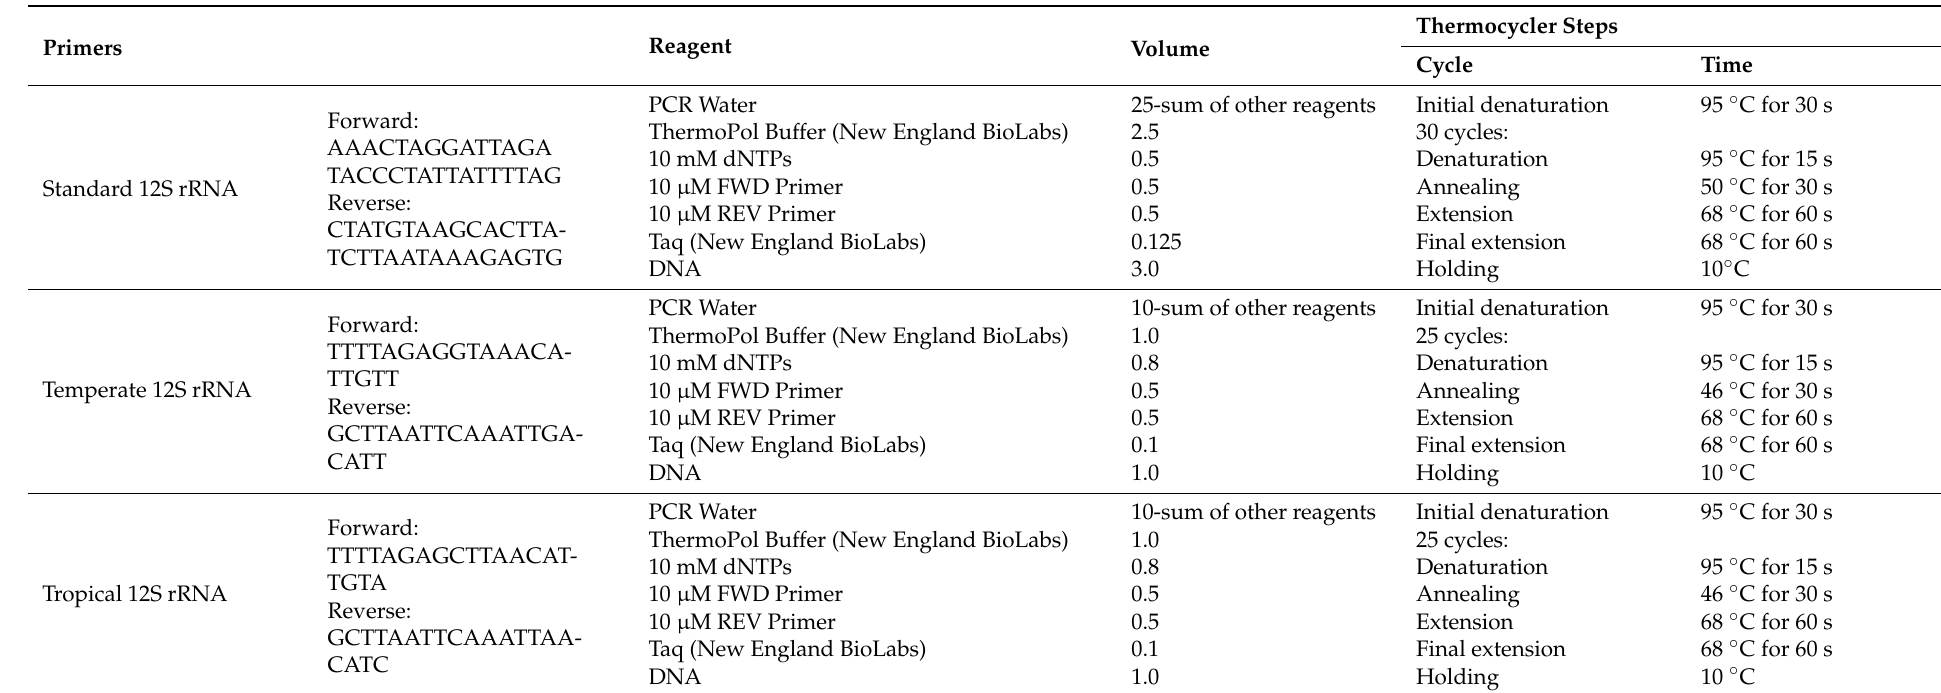
Table 1. Standard and diagnostic 12S rRNA PCR protocol for R. sanguineus s.l. lineage